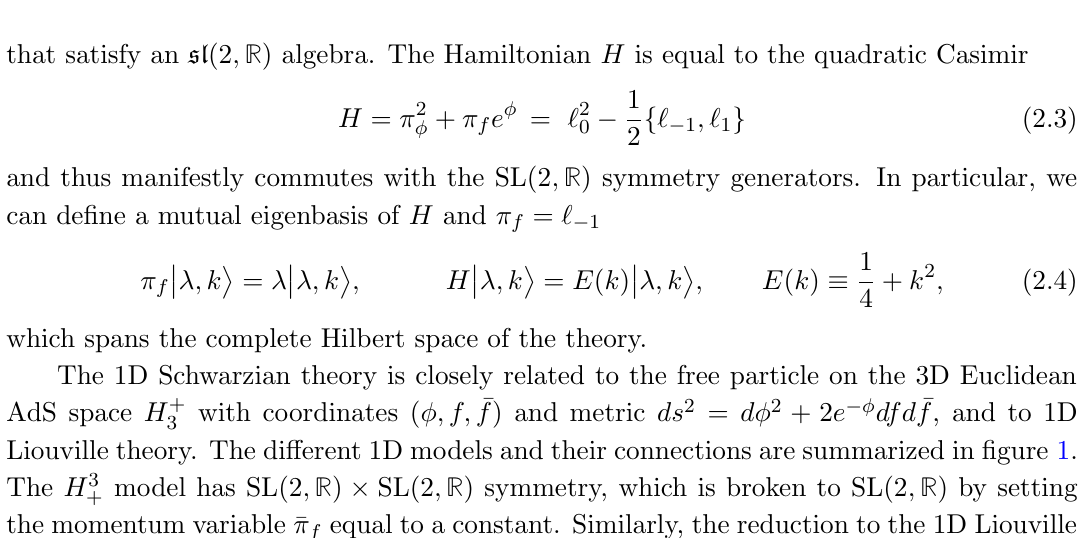
Figure 1 . Overview of di(cid:11)erent models with underlying SL(2 ; R ) symmetry. Red lines indicate one-way lines: they are projections that reduce the dimension of the phase